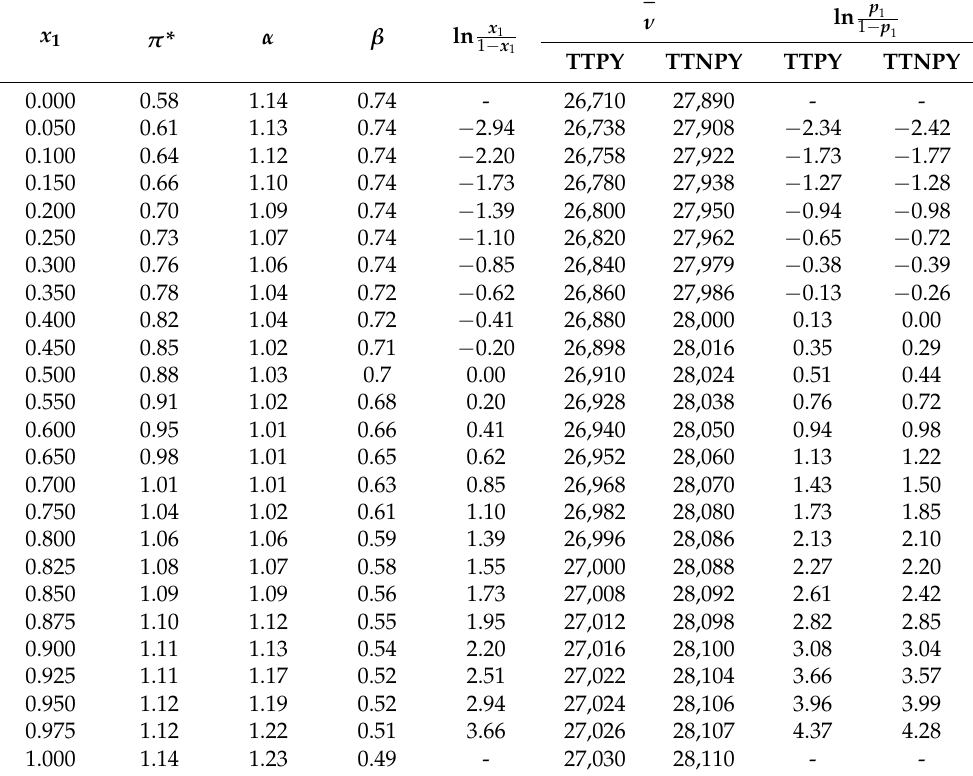
Table 2. Molar water composition ( x 1 ), Kamlet–Abboud–Taft parameters ( π *, β , α ) of binary solvent